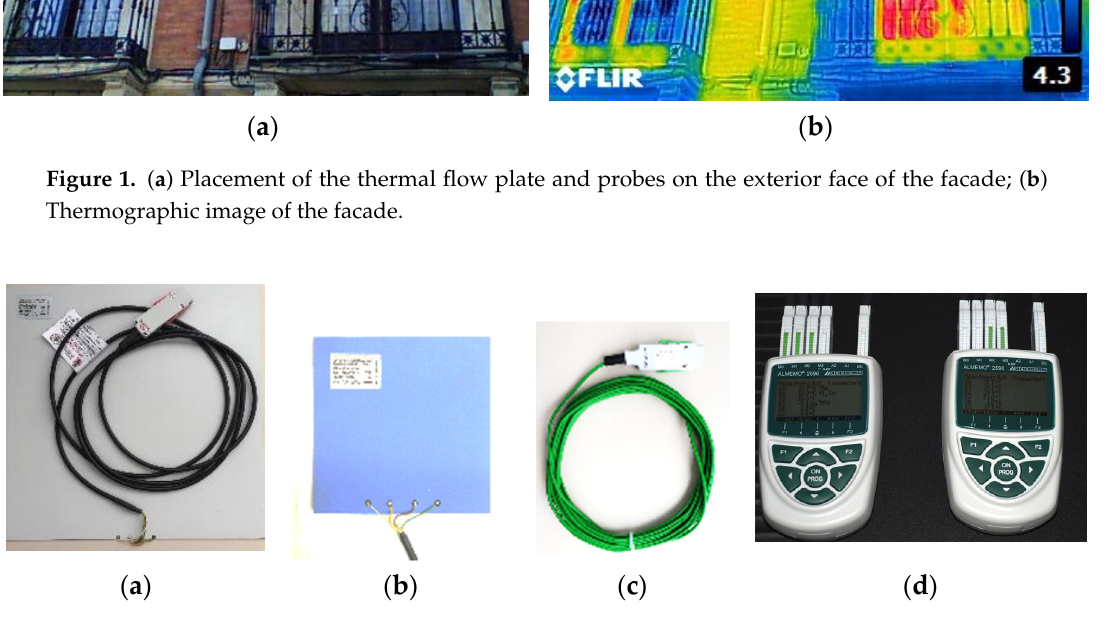
Figure 2. ( a ) Thermal flow plate placed inside; ( b ) thermal flow plate placed outside; ( c ) thermocouple; ( d ) data logger.